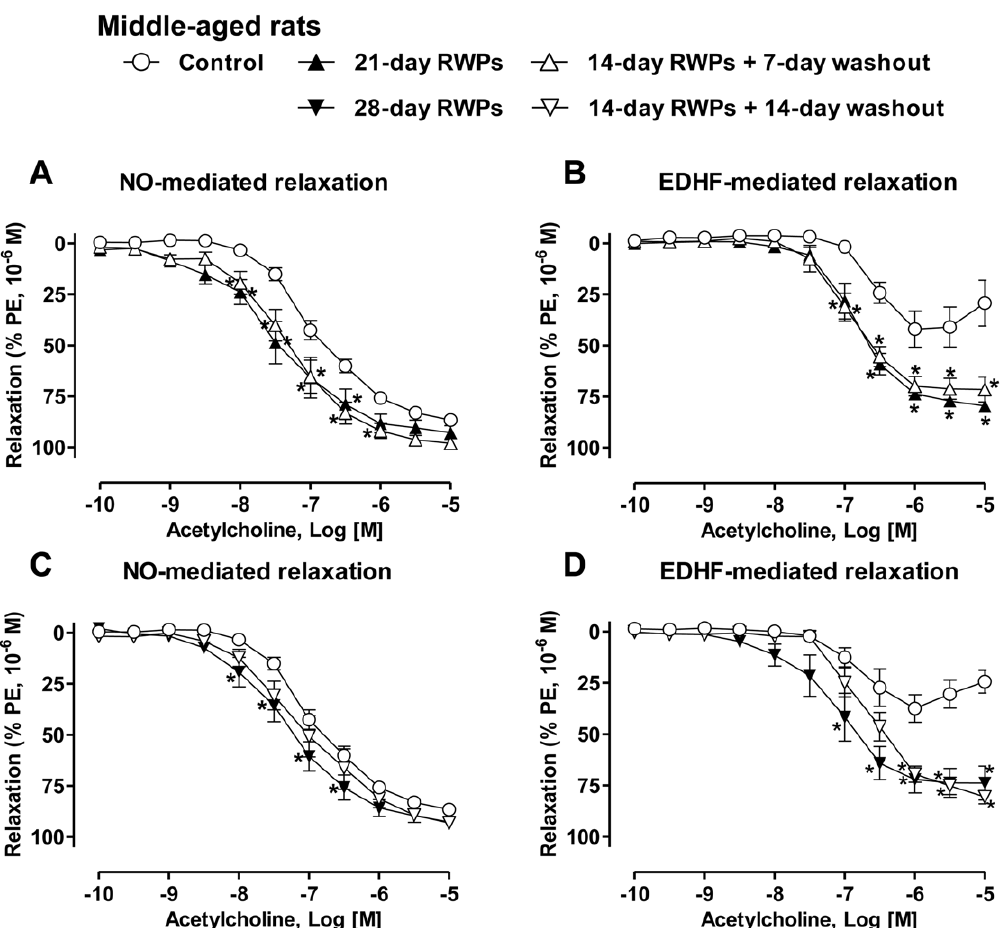
Figure 3. The RWPs-induced Improvement of endothelial dysfunction in the mesenteric artery persists after 7 and 14-day washout periods. Middle-aged rats (46-week old) received RWPs (100 mg/kg/day) in the drinking water for either 21 days or 14 days followed by a 7-day washout period (a, b), and for 28 days or 14 days followed by a 14-day washout period (c, d). NO-mediated relaxations were determined in rings contracted with phenylephrine (1 m M) in the presence of indomethacin (10 m M) and charybdotoxin (CTX, 100 nM) plus apamin (APA, 100 nM) to inhibit the participation of prostanoids and EDHF, respectively (a, c). EDHF-mediated relaxations were recorded in the presence of indomethacin (10 m M) and N v -nitro-L-arginine (L-NA, 300 m M) to rule out the participation of prostanoids and NO, respectively (b, d). Results are shown as means 6 SEM of 5 to 6 rats. * P , 0.05 indicates a significant difference versus the middle-aged rat control group.